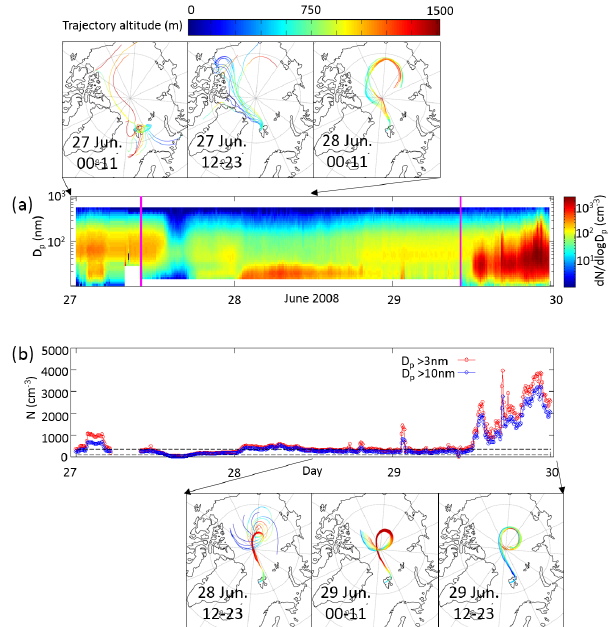
Figure 2. (a) Particle number size concentration measured before, during and after the size-resolved CCN concentration measure- ments were conducted in June 2008. Purple vertical lines indicate the start and end time of the CCN size-resolved concentration mea- surements. (b) Time series of the 8min medians from CPC mea- surements for the same period in June 2008. Horizontal dashed lines represent the 25th and 75th percentile of the CN number concentra- tion for June during the years 2001 to 2010. Trajectory plots show 5-day backward trajectories, calculated for every hour. Trajectory plots on top of panel (a) show air masses arriving between the 27 and midday of the 28 June at the Zeppelin research station. Trajec- tory plots below panel (b) show air masses arriving between midday of the 28 June to midnight of the 29 June at the Zeppelin research